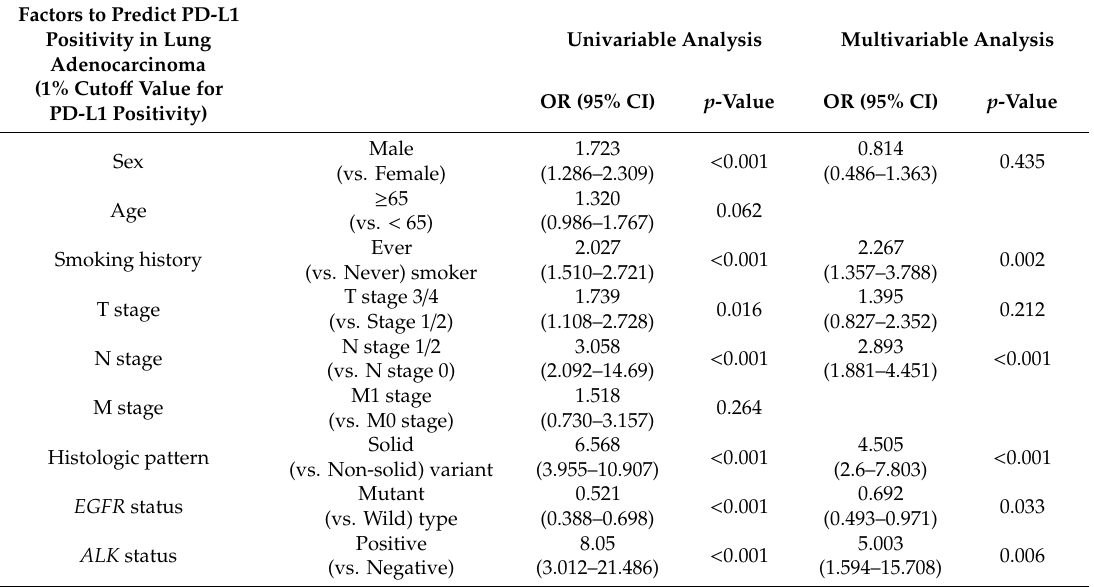
Table 5. Multivariate logistic regression analysis of clinicopathological features for PD-L1 expression